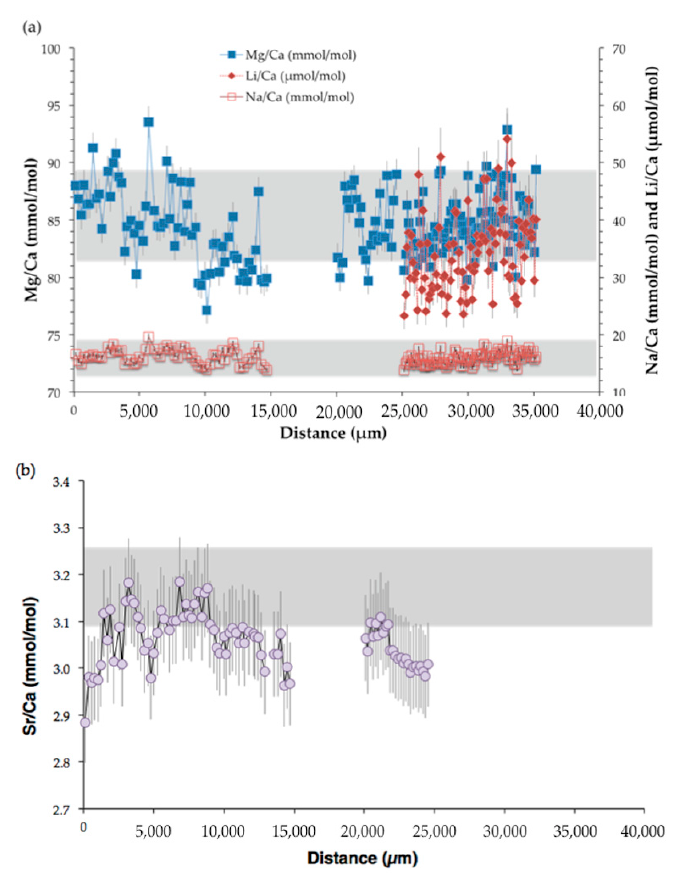
Figure 9. Elemental ratios measured by SIMS relative to the distance ( μ m) from the center to the outermost part of Valpareso sample. ( a ) The primary y -axis represents Mg/Ca (mmol/mol) and the secondary y -axis Na/Ca (mmol/mol) and Li/Ca ( μ mol/mol). ( b ) Sr/Ca (mmol/mol) versus the distance ( μ m). In the two panels, the grey area stands for the range of bulk measurements (note that Li/Ca ratios were not measured in bulk). Error bars are ±2 σ .